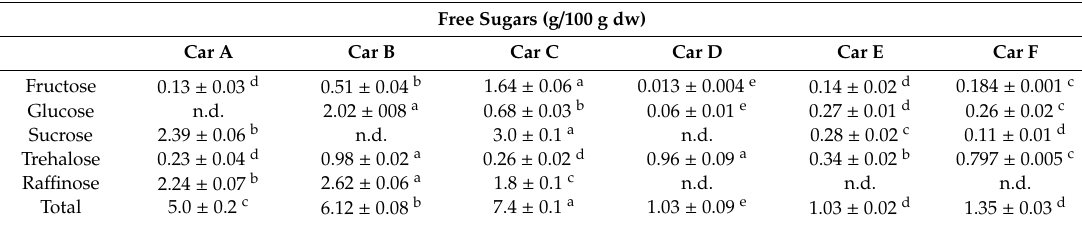
Table 4. Free sugars composition (g / 100 g dw) of Cynara cardunculus heads in relation to maturity stage (mean ± SD; n =